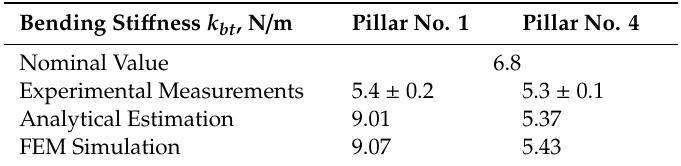
Table 2. The bending sti ff ness of nanopillars determined by experimental investigations and analytical